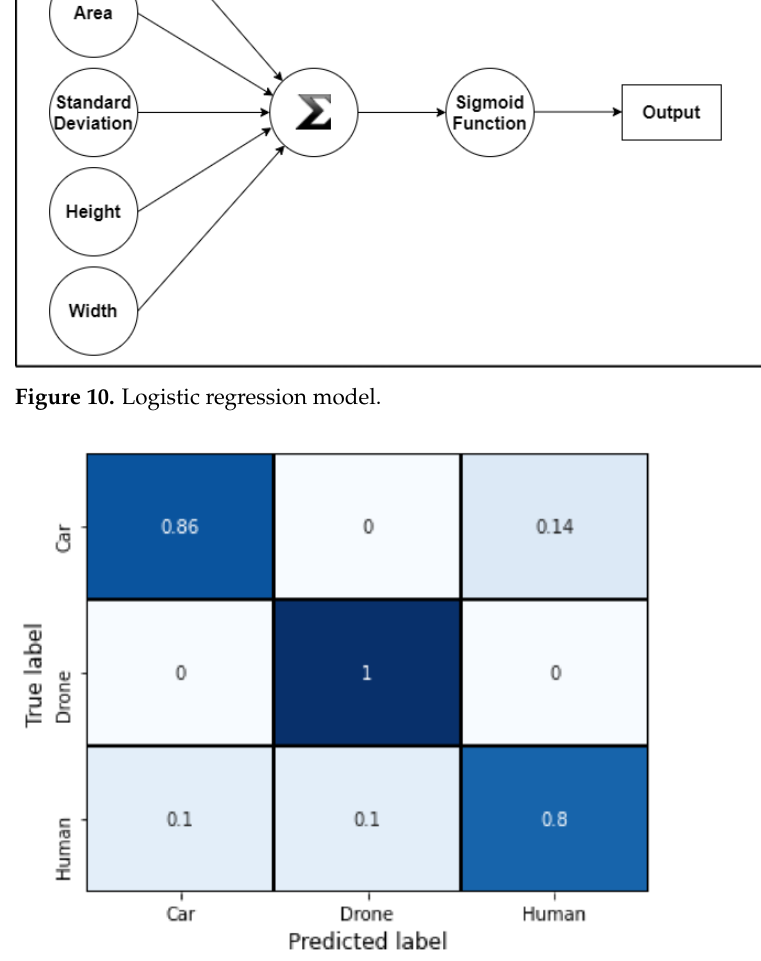
Figure 11. Logistic regression model’s confusion matrix on test